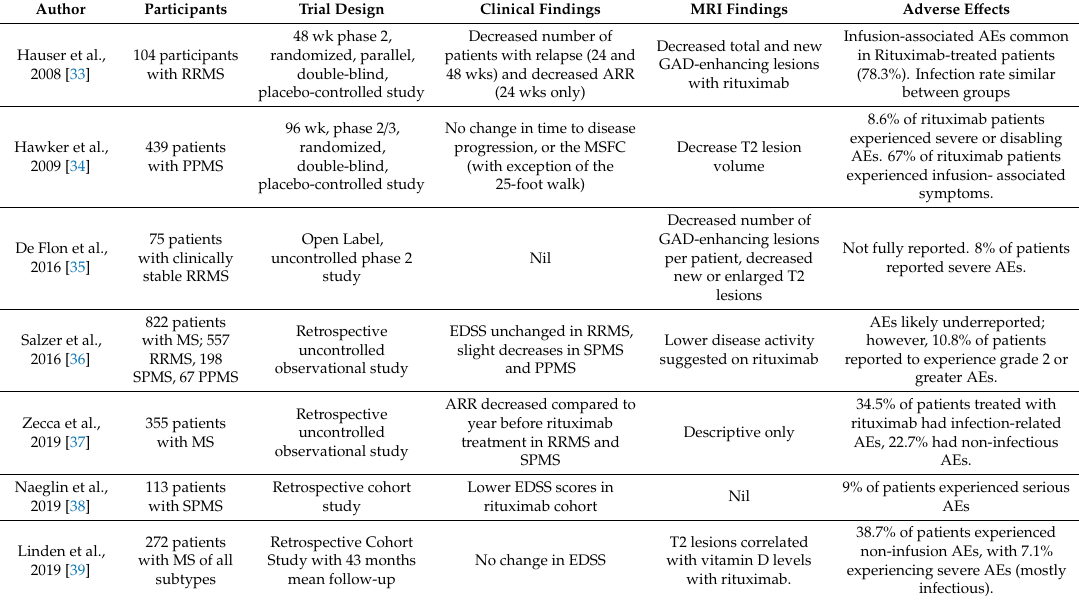
Table 1. A Summary of Clinical Studies Using